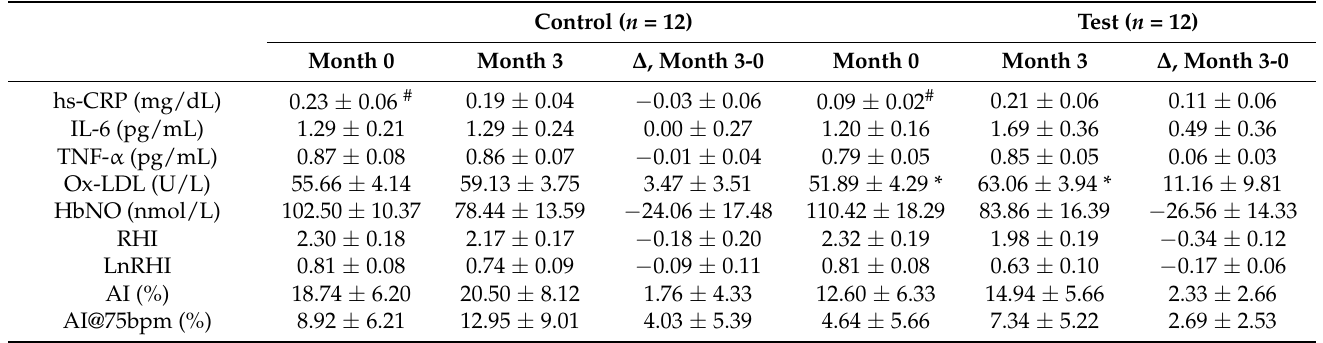
Table 5. Changes in inflammation, oxidative stress and vascular health parameters between start and end of study. Control ( n = 12) Test ( n =